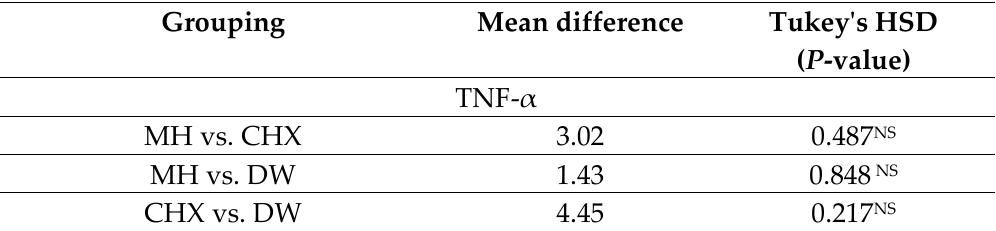
Table 3: Intergroup comparisons of mean values of TNF- α between all pairs of groups after mouthwash use.